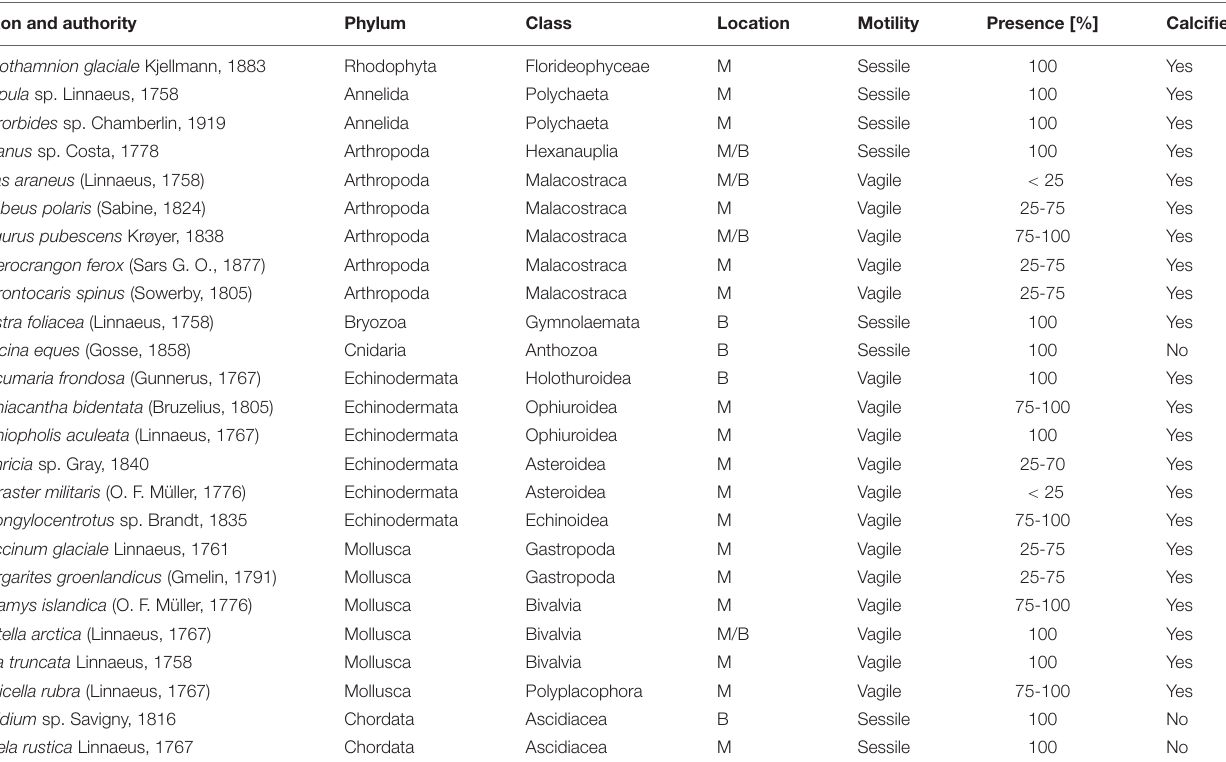
TABLE 5 | Macrobenthos species inventory of organisms identified in the image stacks of the lander’s camera system, with reference to the location (M, Mosselbukta; B, Bjørnøy-Banken), their motility, and their temporal presence in four percent classes. Taxon and